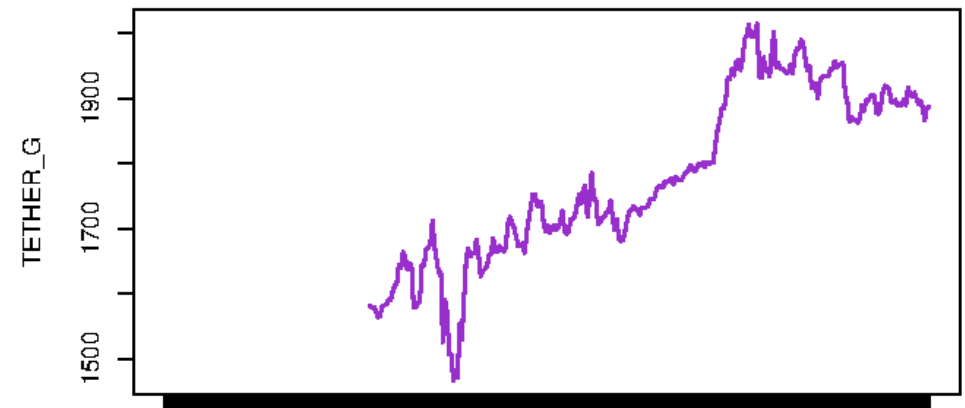
Figure 9. Price of Tether Gold (TETHER _